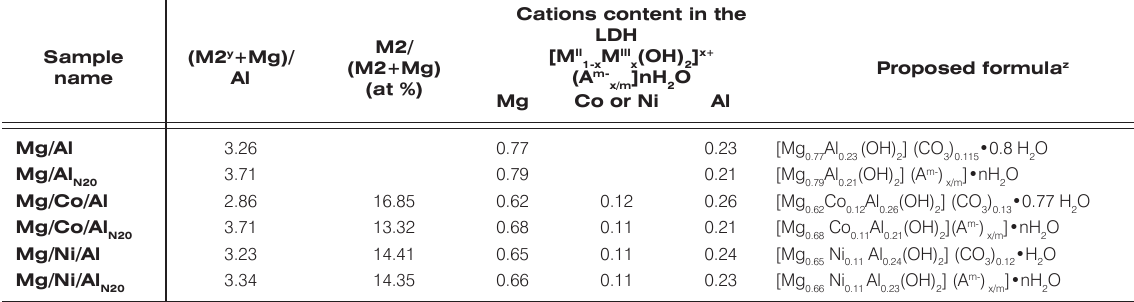
Table 2. XRF analysis data obtained for as synthesized and regenerated in the magnesium nitrate LDH